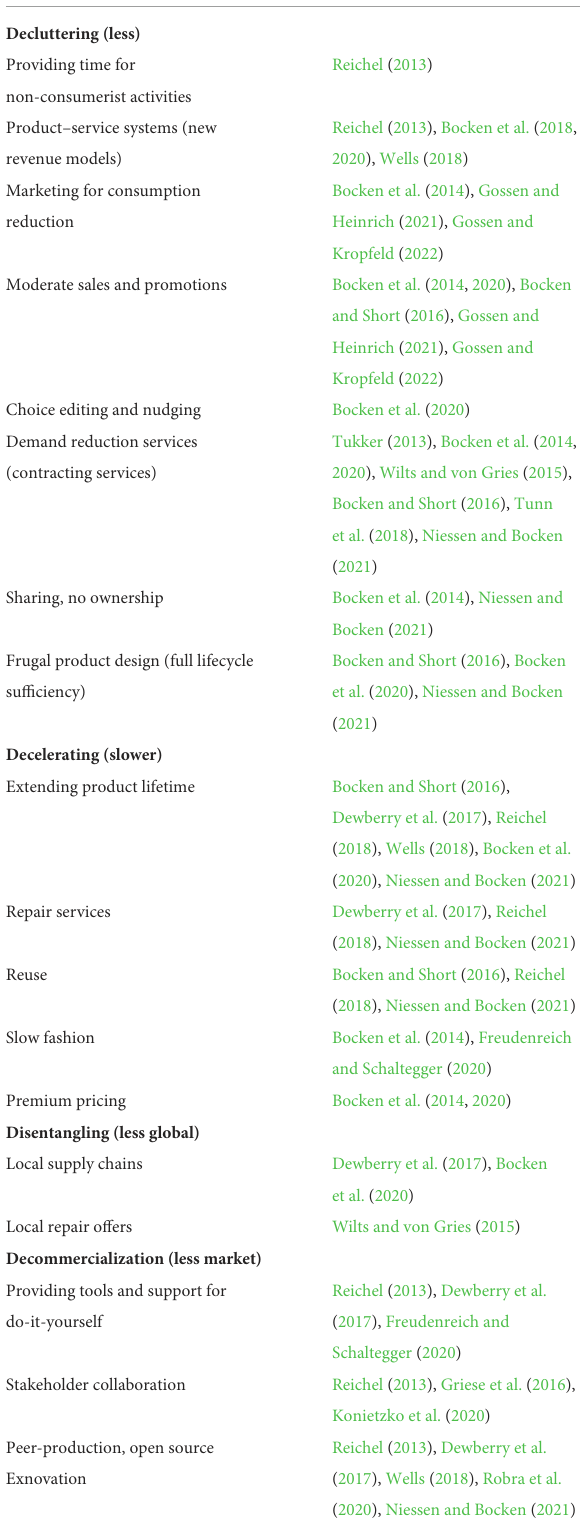
TABLE 1 Existing sufficiency-oriented strategies in sufficiency and sustainable business model literature.